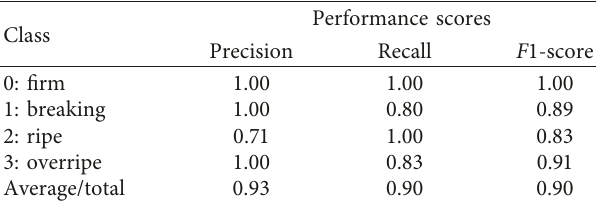
Figure 5: Principal component analysis (PCA2 vs. PCA1) over EIS responses: (a) impedance magnitude, (b) negative phase angle, (c) real part of impedance, and (d) imaginary part of impedance. Table 1: Performance scores of proposed